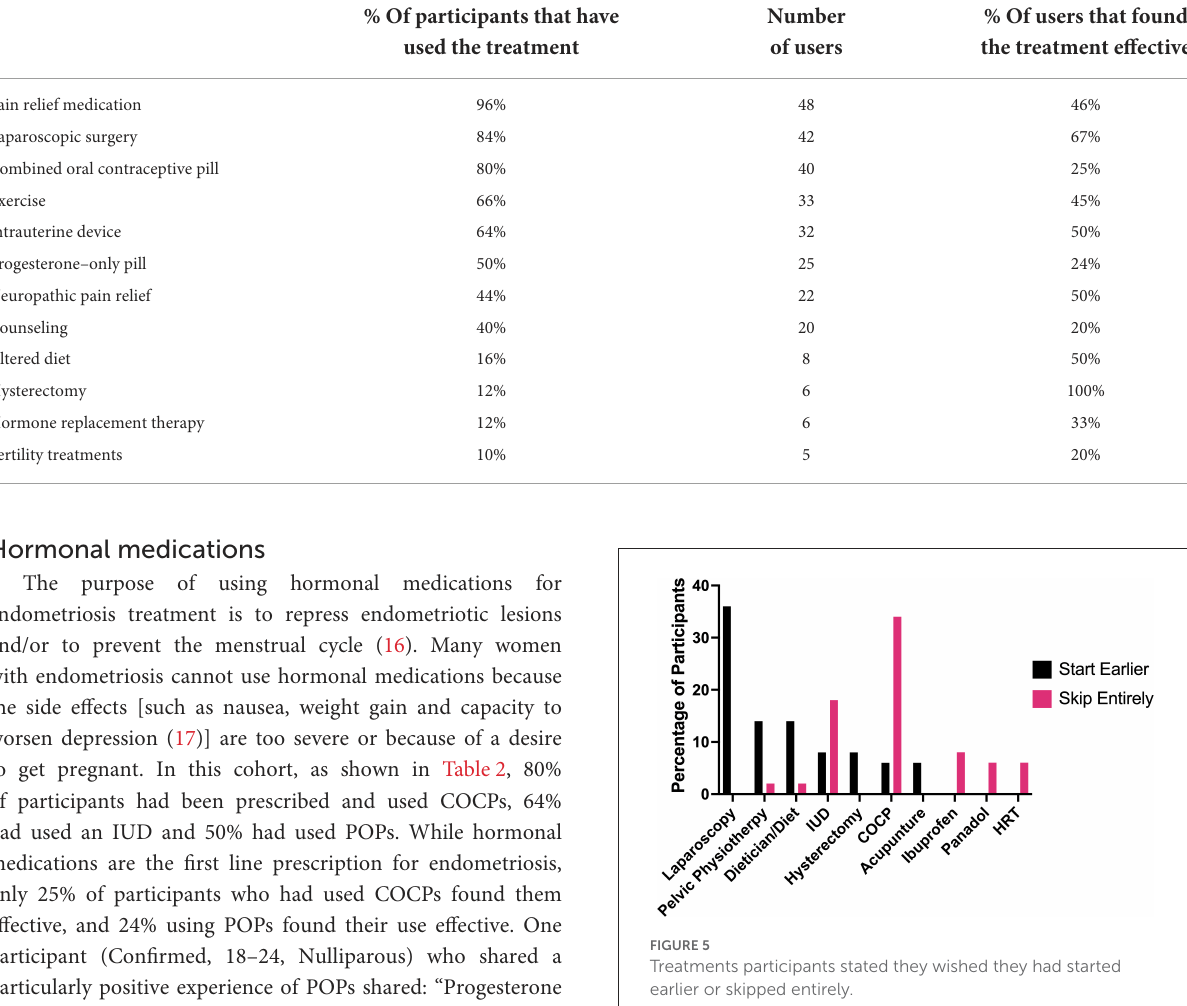
Number % Of users that found of users the treatment